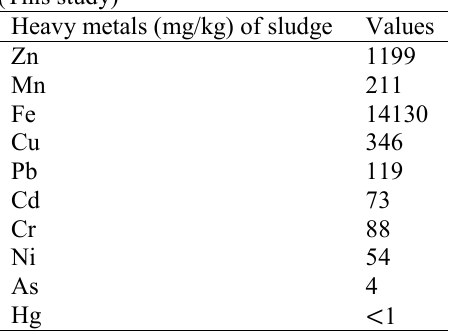
Table 7. Chemical analysis of sludge released by WWTP effluent before joining river Musi, Amberpet, Hyderabad (This study) Heavy metals (mg/kg) of